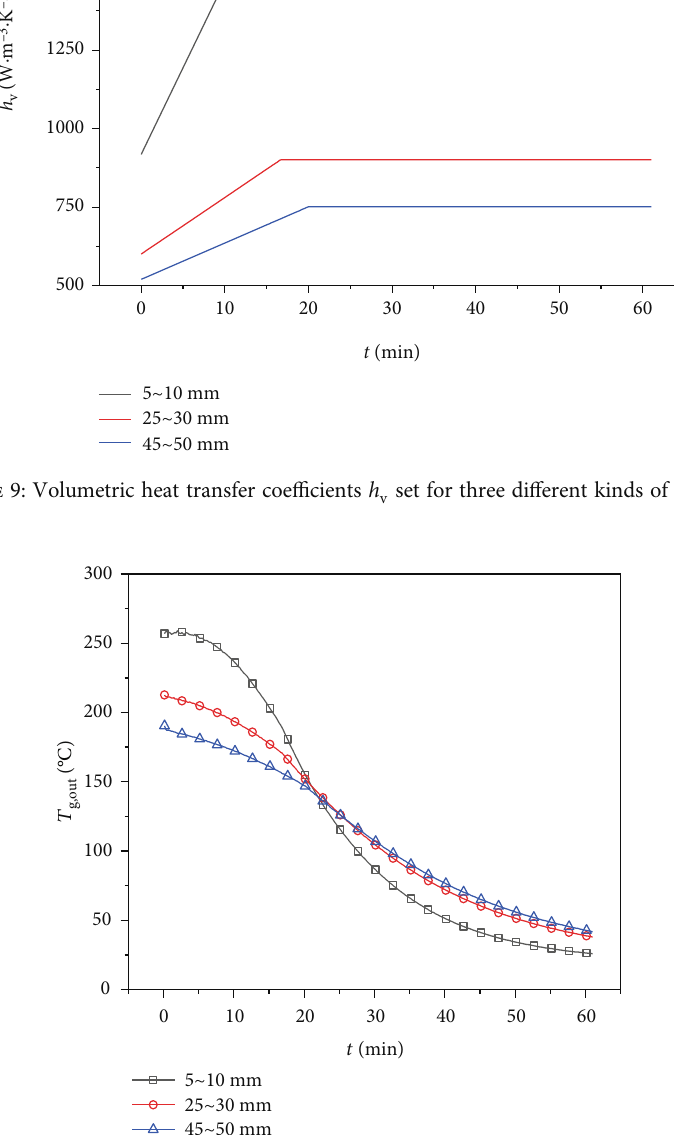
of three kinds of sinters based on the set heat transfer coe ffi g,out